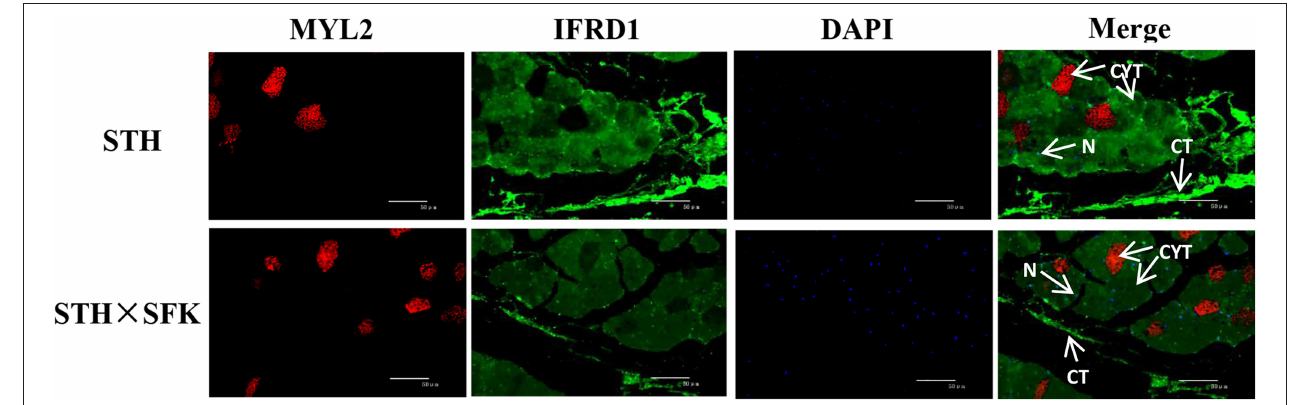
FIGURE 6 | Expression location of MYL2 and IFRD1 protein in STH and STH × SFK longissimus dorsi muscle (IF × 400). CYT, Cytoplasm; N, Nucleus; CT, Connective